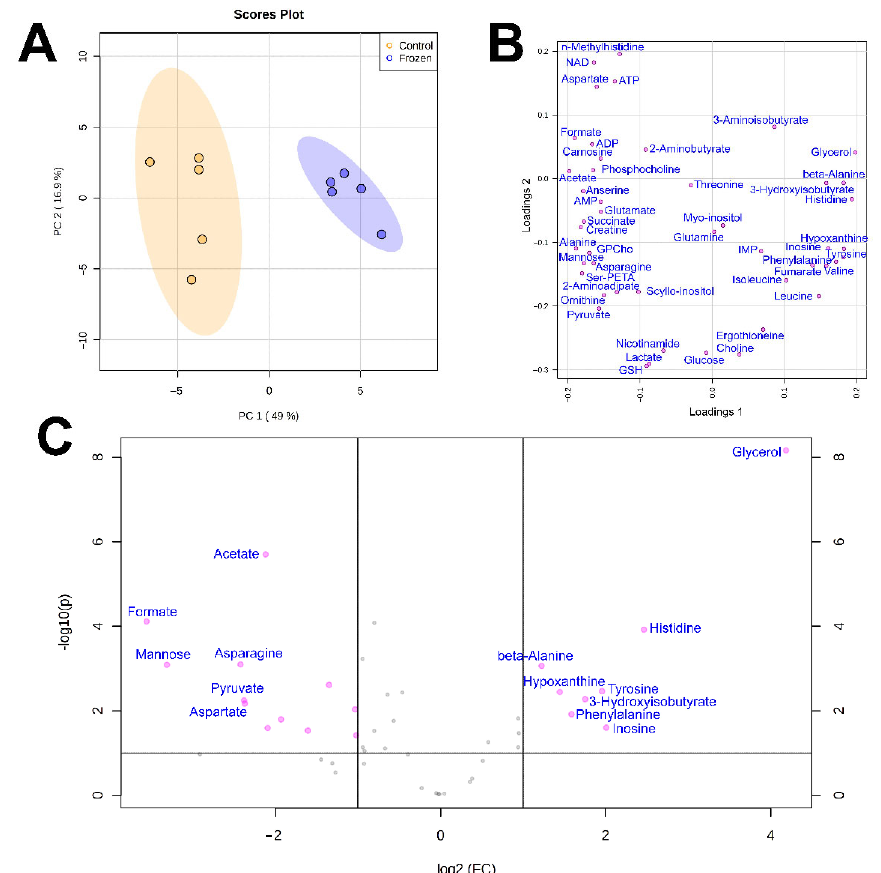
Figure 2. ( A ) Scores plot of the principal component analysis (PCA) of hindlimb muscle metabolomic profiles of frozen (blue) and control (yellow) individuals of S. keyserlingii . The data are range scaled. Colored ovals indicate 95% confidence regions. Variance explained by the first (PC1) and second (PC2) principal components is indicated on the axis of scores plot. ( B ) Loadings plot for the same data. ( C ) Volcano plot for frozen and control muscle samples.